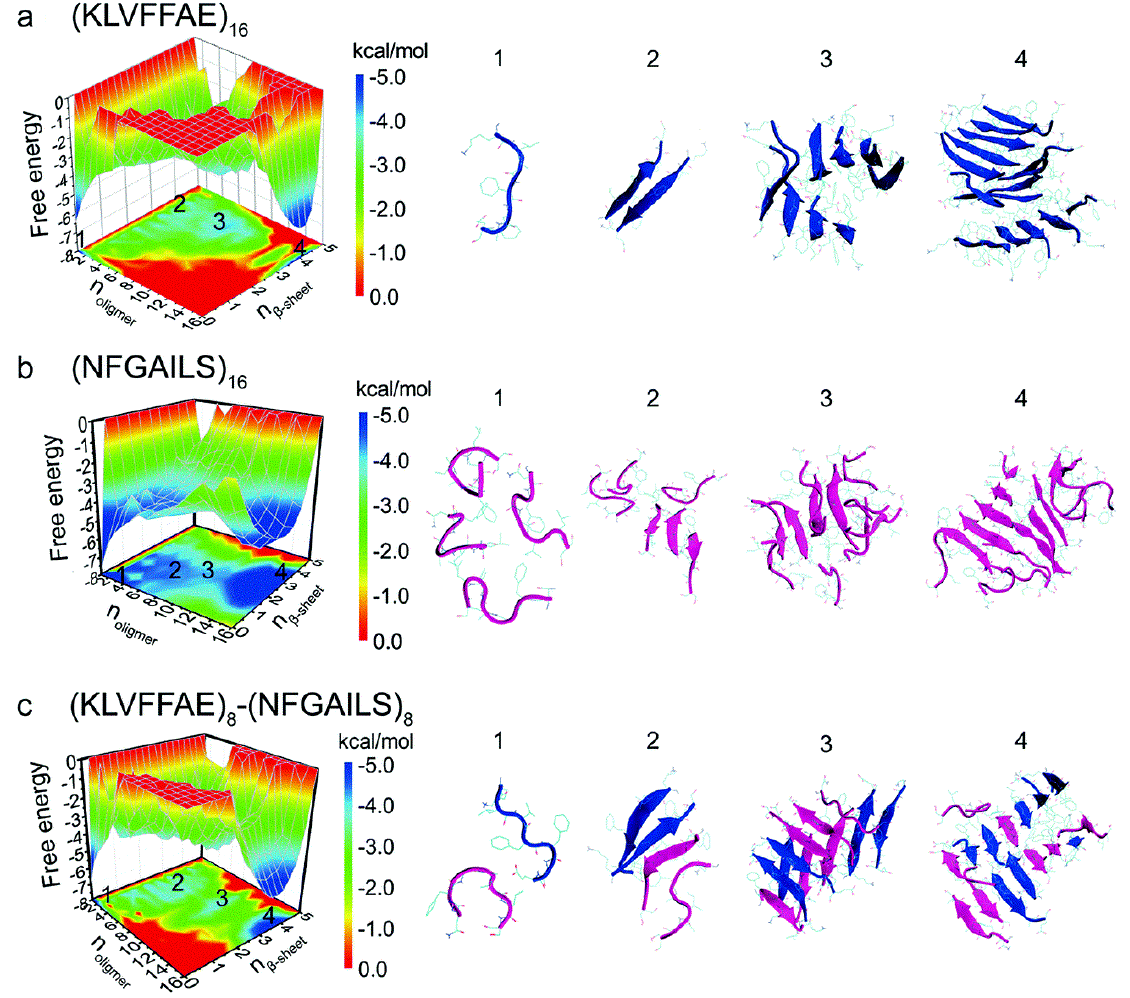
Figure 19. Free energy landscape and cluster representatives in each free energy minima: ( a ) Aβ 16–22 , ( b ) hIAPP 22–28 , and ( c ) Aβ 16–22 -hIAPP 22–28 . Adapted from Sun et al. [119]. Copyright 2013 American Chemical Society.